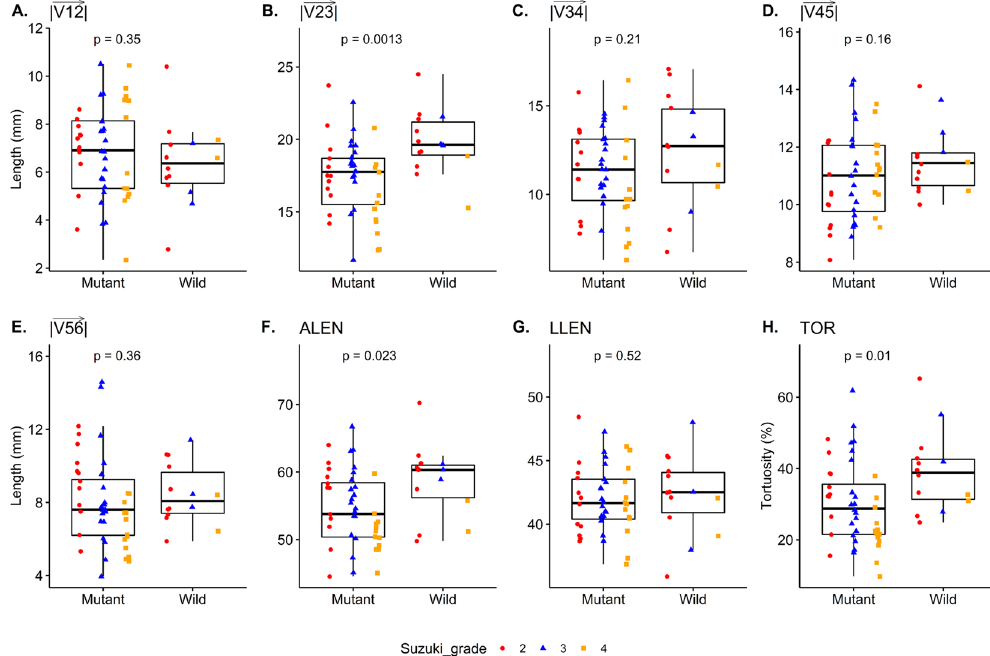
Figure 2. Bar plots with jitters show the distribution of the lengths and corresponding p-values. The shape and color of each jitter represents the Suzuki grade. → segment; V34 , vertical cavernous segment; segments; ALEN, actual length; LLEN, linear length; TOR,